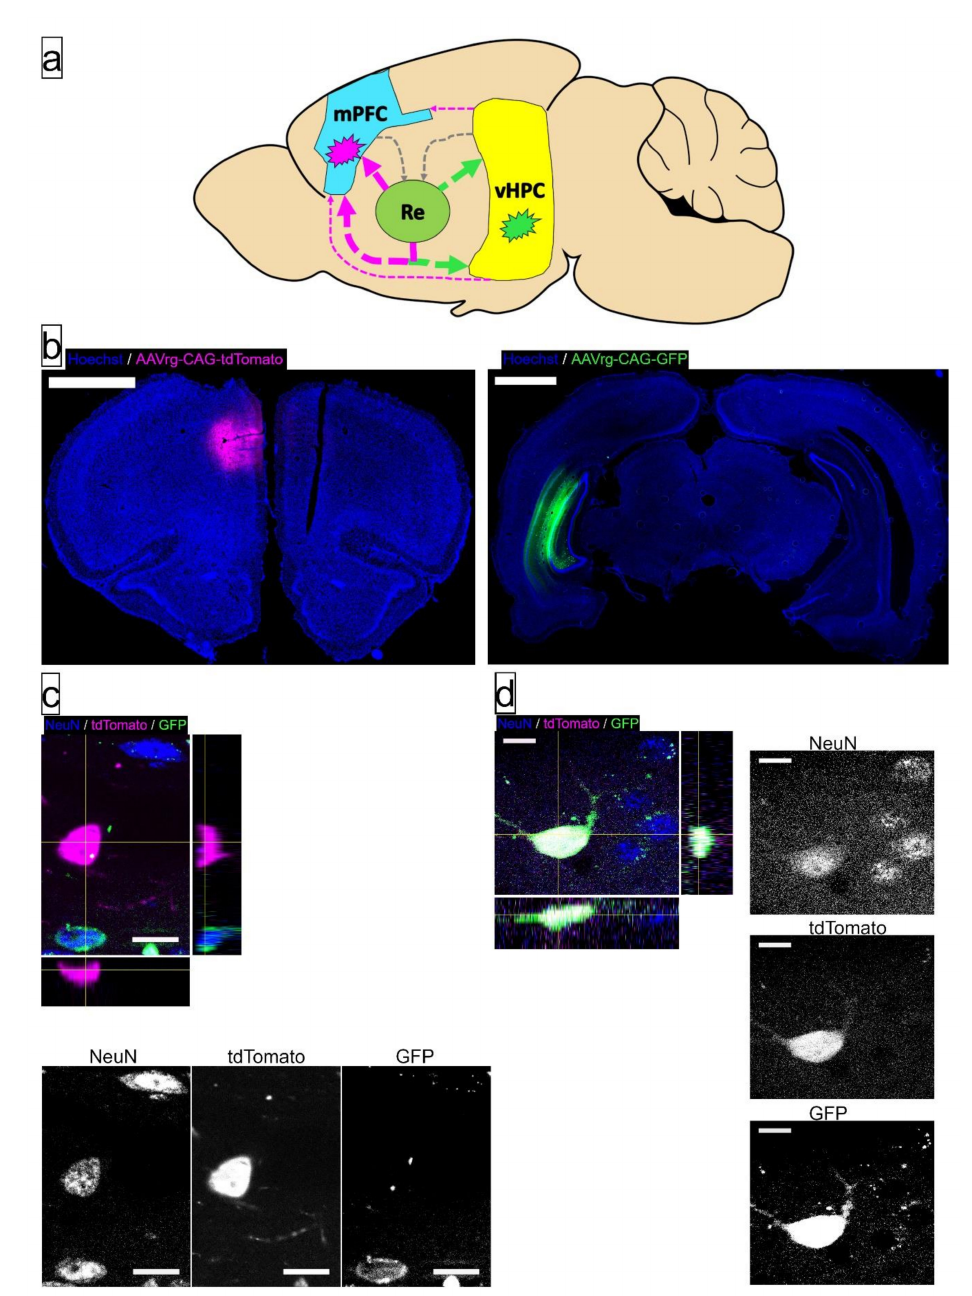
Figure 2. Schematic representation and visualization of retrograde-labeling AAVrg-CAG injections into medial prefrontal cortex (mPFC), ventral hippocampus (HPC), and exemplar labeled cells in thalamic nucleus reuniens (Re). ( a ) A schematic indicating the approximate sites of AAV injection (indicated by magenta and green explosion symbol). Connectivity within mPFC-Re-HPC circuitry is presented as arrows, with the large, colored, arrows leaving Re as the population of projection neurons examined. Pairing of injection site and fluorophore was counterbalanced between postnatal treatment and sex. Connectivity diagram is derived from [48,49]; ( b ) Representative sections containing the center of the injection site into mPFC (left) and HPC (right). Scale bars = 2 mm; ( c ) Examples of Re projection neurons (NeuN + ) projecting to the injection site of AAVrg-CAG-tdTomato (NeuN + /GFP − /tdTomato + , in crosshairs), AAV-CAG-GFP (NeuN + /GFP+/tdTomato+, bottom left), or neither injection site (NeuN + /GFP − /tdTomato − , top right). Bars on right and bottom of image show Y-Z and X-Z planes of image stack, respectively, while the panels below show each color channel in isolation. Scale bar = 15 µ m; ( d ) A subpopulation of neurons in Re project to both mPFC and HPC, as indicated by expression of fluorophores from both injection sites (NeuN + /GFP + /tdTomato + , in crosshairs). Bars on right and bottom of image show Y-Z and X-Z planes of image stack, respectively, while the panels on the right show each color channel in isolation. Scale bars = 15 µ